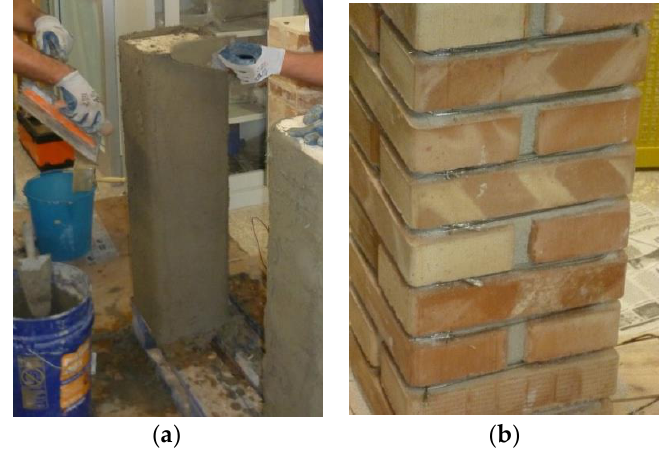
Figure 3. Preparation of specimens: ( a ) basalt-reinforced specimen; ( b ) specimen reinforced with steel wires.